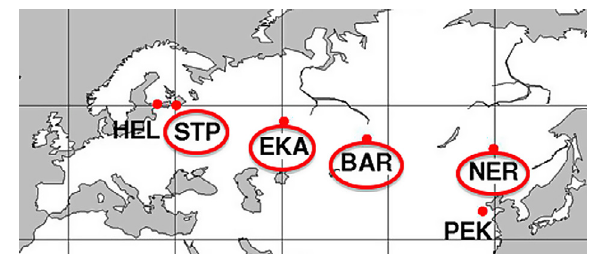
Fig. 1. Russian observatories in the 1800s used in this study are marked by a red oval. Figure modified from Nevanlinna & Ha¨kkinen (2010).